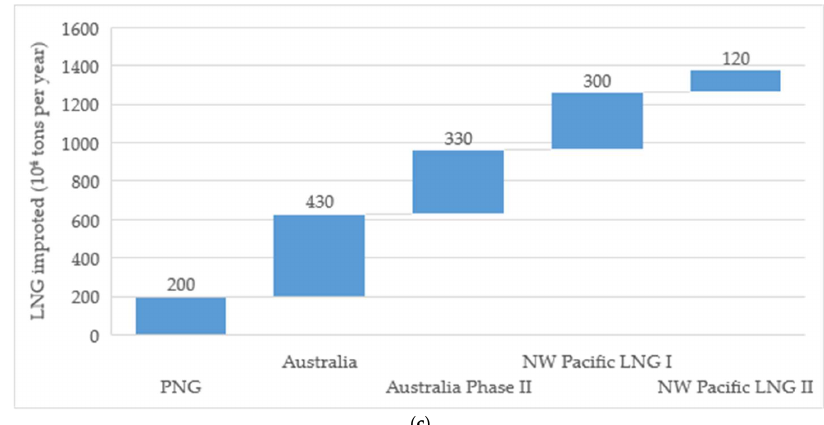
Figure 4. Imported LNG contract amounts of CNPC CNOOC and Sinopec. Notes: ( a ) presents the contract amount of CNOOC’s import LNG by 2030, ( b ) presents that of CNPC’s and ( c ) presents that of Sinopec’s. TRP means Total Resources Portfolio, BPRC is BP resource combination, Shell RM is Shell Resource Mix, MA is Mobil Australia and PNG is Papua New Guinea.